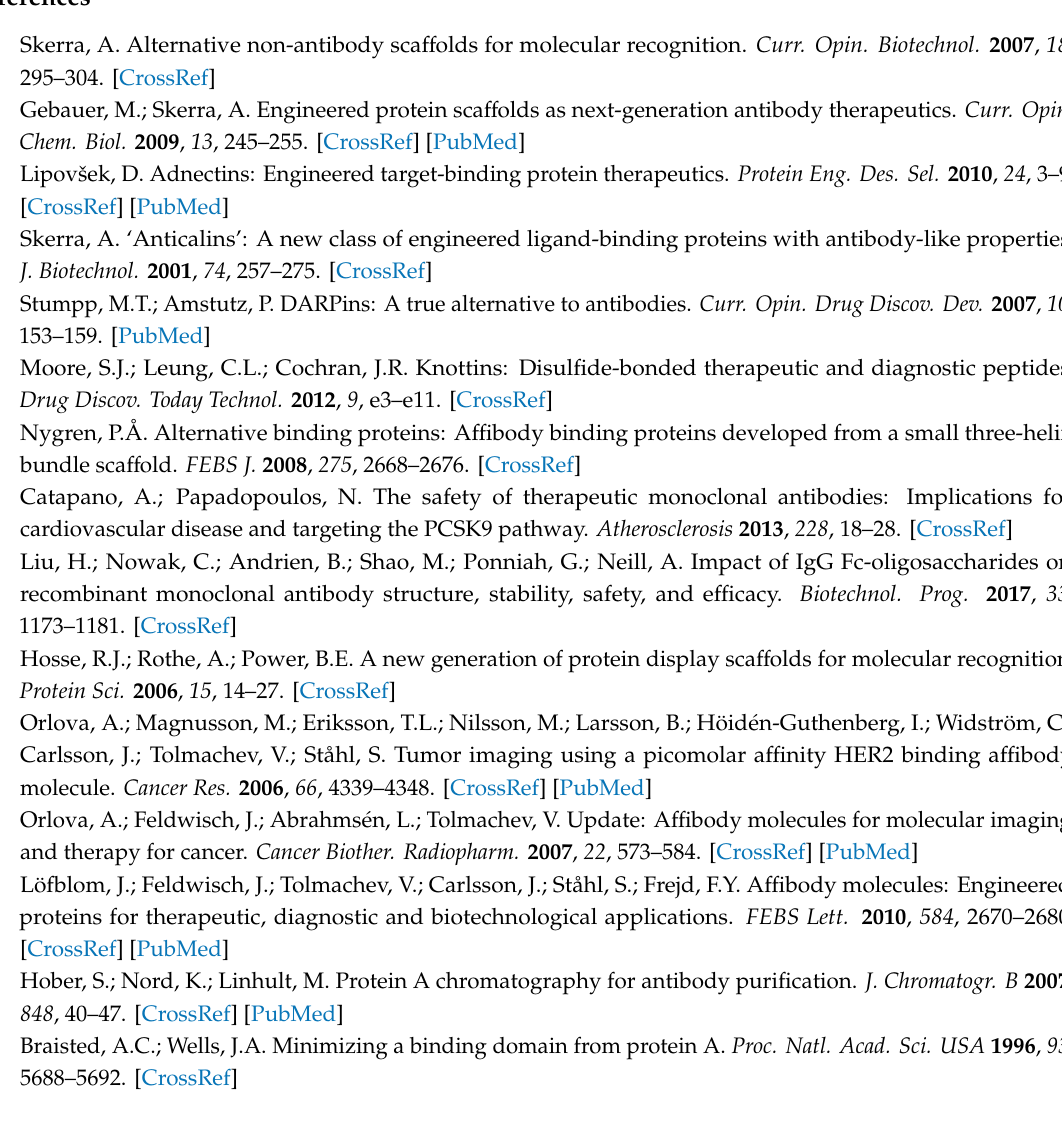
Figure A4. Correlation between equilibrium binding capacity of anti-HSA affibody onto ( ■ ) IGKQRI–GSG–Toyopearl resin and ( ♦ ) HSA–Toyopearl resin. Binding studies were performed in triplicate.